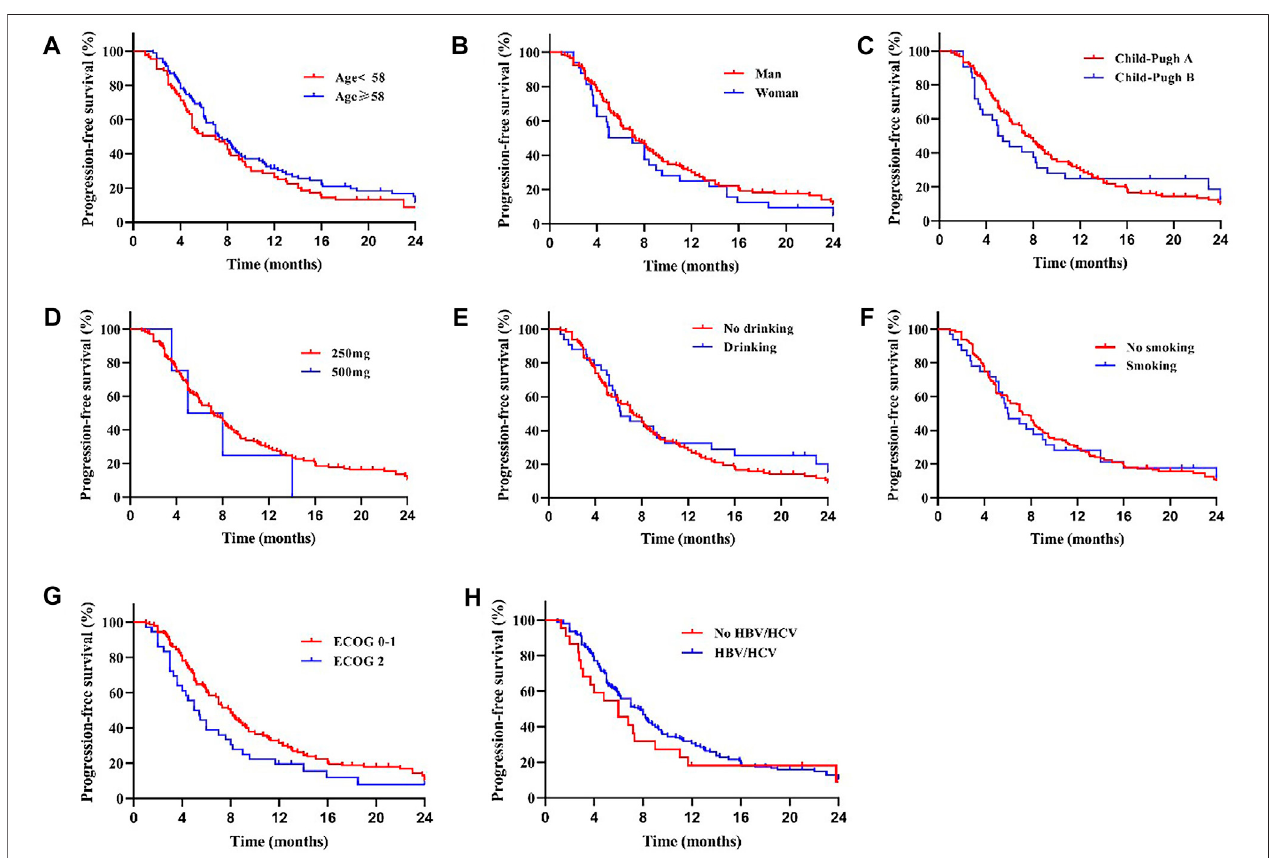
FIGURE4| Therewasnosigni fi cantdifferenceinmPFSbetweenpatientswithdifferentage (A) ,sex (B) ,Child-Pughclass (C) ,drugdose (D) ,whetherwithdrinking (E) or smoking (F) history, ECOG scores (G) and whether with HBV/HCV (H) (All p > 0.05).